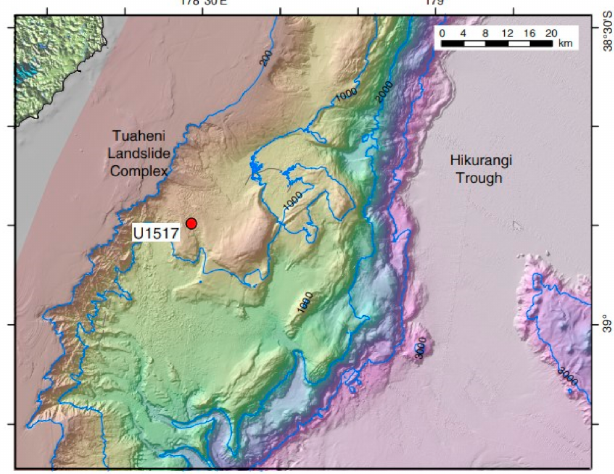
Figure 2. Location of U1517A wellsite in the Tuaheni Landslide Complex, New Zealand during IODP Exp. 372A. Modified after